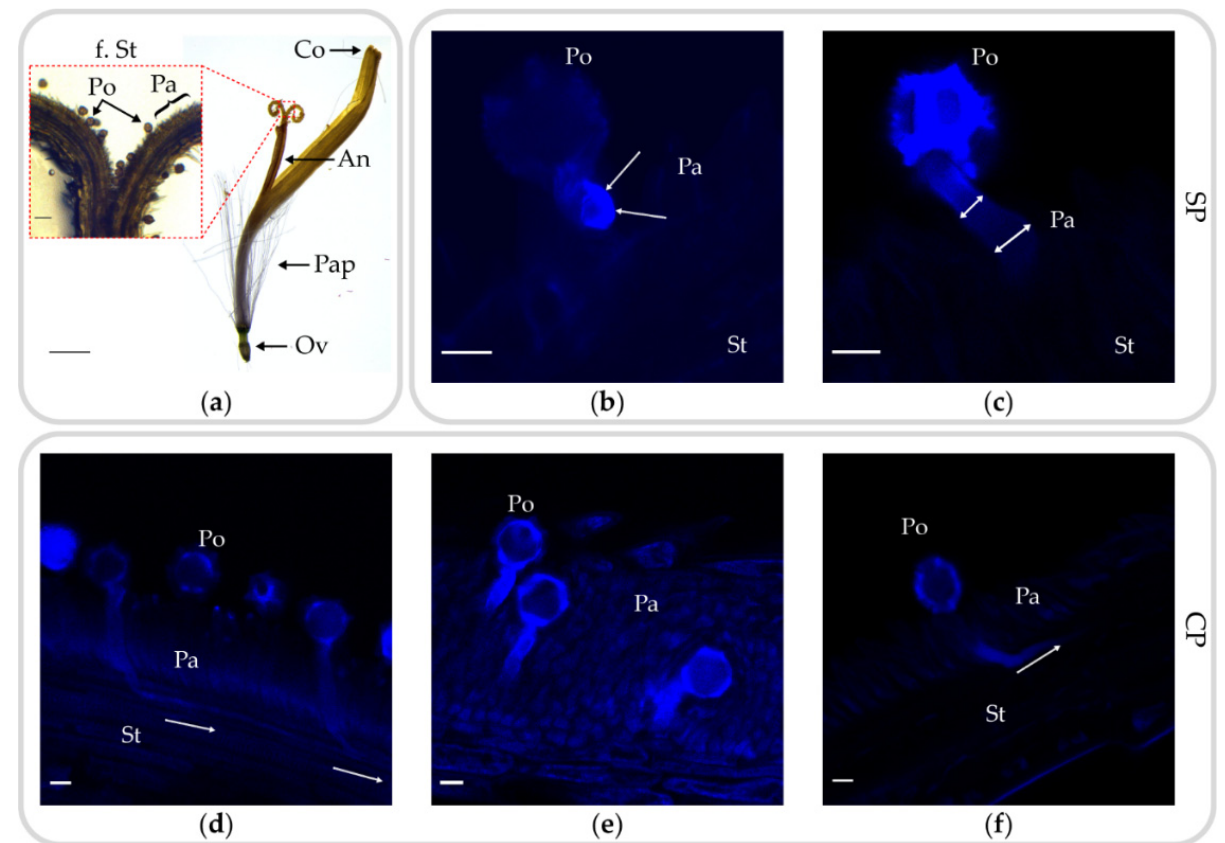
Figure 2. Lateral overview of a T. koksaghyz floret as well as incompatible (TKMS2xTkMS2) and compatible (TkMS3xTkMS2) pollen–stigma interactions revealed by confocal laser scanning microscopy. ( a ) Overview of a T. koksaghyz floret after the onset of flowering, showing inferior ovary (Ov), pappus (Pap), anther tube (An) and corolla (Co). The red-dotted section shows exemplarily the expected site of pollen (Po) recognition on the papilla (Pa) cell area of the forked stigma (f. St). ( b) Lactic acid fixation of self-pollinated (SP) TkMS2. The germinated pollen tube shows strong aniline blue staining on the wall at the apex (white arrows). ( c ) SP of TkMS2. The germinating pollen tube can be traced to the papilla cells, where the pollen tube appears swollen and no pollen tube is observed within the stigma (double-headed arrows). ( d , e ) Lactic acid fixation of cross-pollinated (CP) TkMS2xTkMS3. ( d ) Several pollen grains are visible on the papilla surface, with two pollen tubes emerging and penetrating the stigma (white arrow). ( e ) Pollen tube growth between papilla cells. ( f ) The germinated pollen tube of the compatible pollination can be traced from the pollen and penetrates a short distance into the stigma before the signal disappears (white arrow). Scale bars in ( a , bottom left) = 250 µm, ( a , red-dotted section) = 50 µm and in ( b - f) = 10 µm. Staining time (t) in ( b ) = 60 min, ( c ) = 24 h, ( d ) = 30 min, ( e ) = 40 min, ( f ) = 24 h. Abbreviations ( b–f ): Pa, papilla cells; Po, pollen; St, stigma.